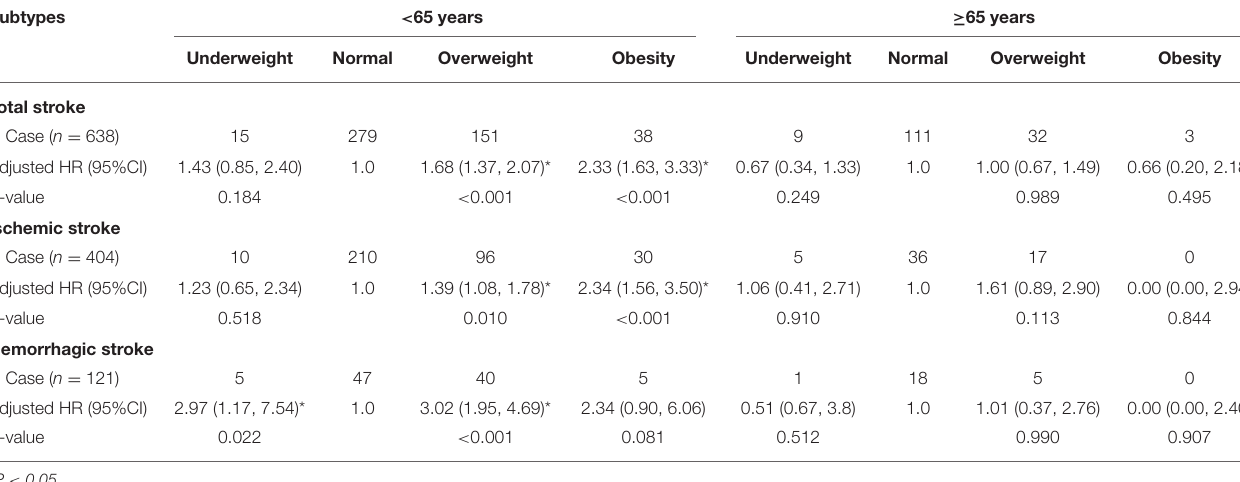
TABLE 4 | Association of BMI with total, ischemic, and hemorrhagic stroke by age using Cox regression analysis. Subtypes < 65 years ≥ 65 years Underweight Normal Overweight Obesity Underweight Normal Overweight Obesity